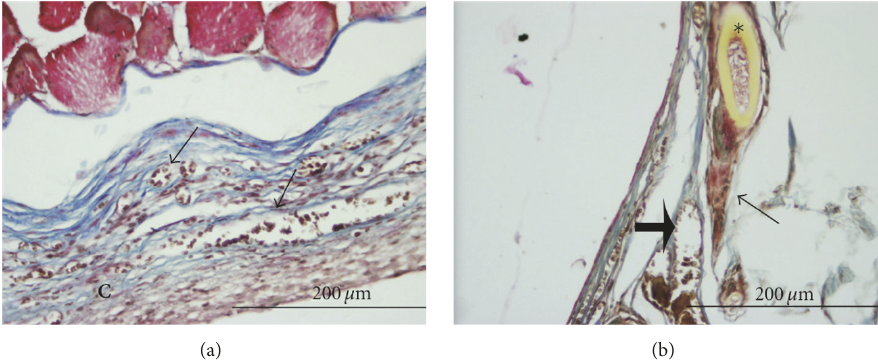
Figure 3: (a) Histological examination of wound tissue after applying gold/polypropylene/poly(ethylene glycol)2000 nanoparticles where arrows indicate inflammatory cells and newly formed blood vessels. C refers to capsule formation after applying the dressing. (b) Histological examination of wound tissue after applying gold/polypropylene/poly(ethylene glycol)4000 nanoparticles where thick arrow indicates neovascularization and thin arrow indicates giant cell accumulation [27] (figure obtained from an open access article distributed under the Creative Commons Attribution